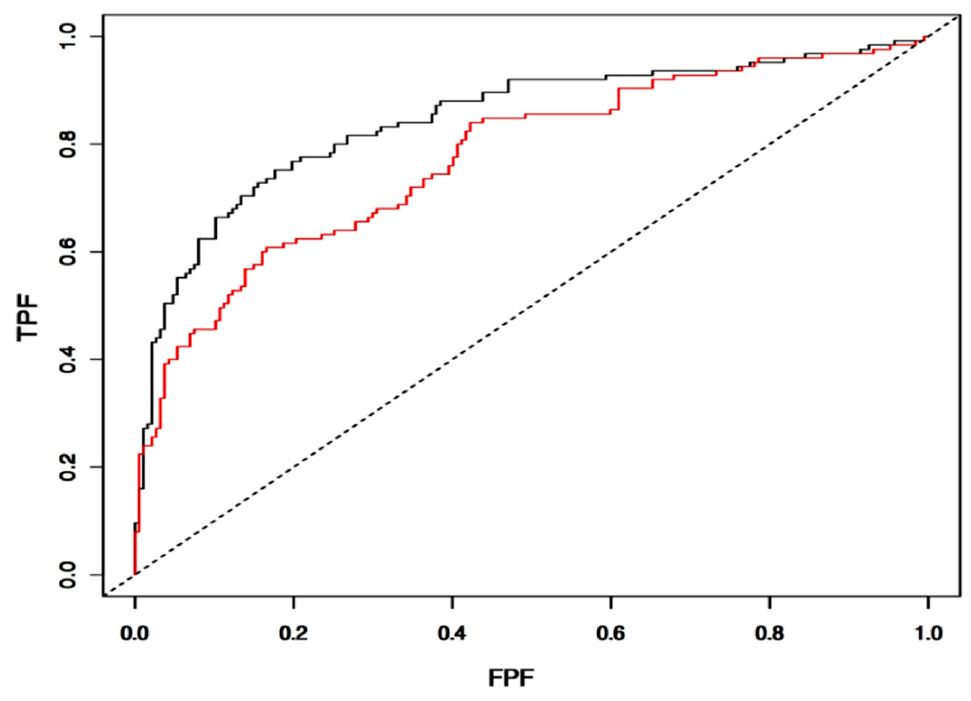
Figure 7. The figure above shows our ROC curve for IntegralVac’s performance accuracy for all overall predictions. The area under the curve quantifies the model’s ability to predict and sort epitope subunits with great accuracy; as a large area is seen in the figure, the data suggests that accuracy is relatively high. Predictions were generated for overall validation of IntegralVac by random selection from all peptide datasets, though still segregated by peptide type, i.e., viral vs. tumor